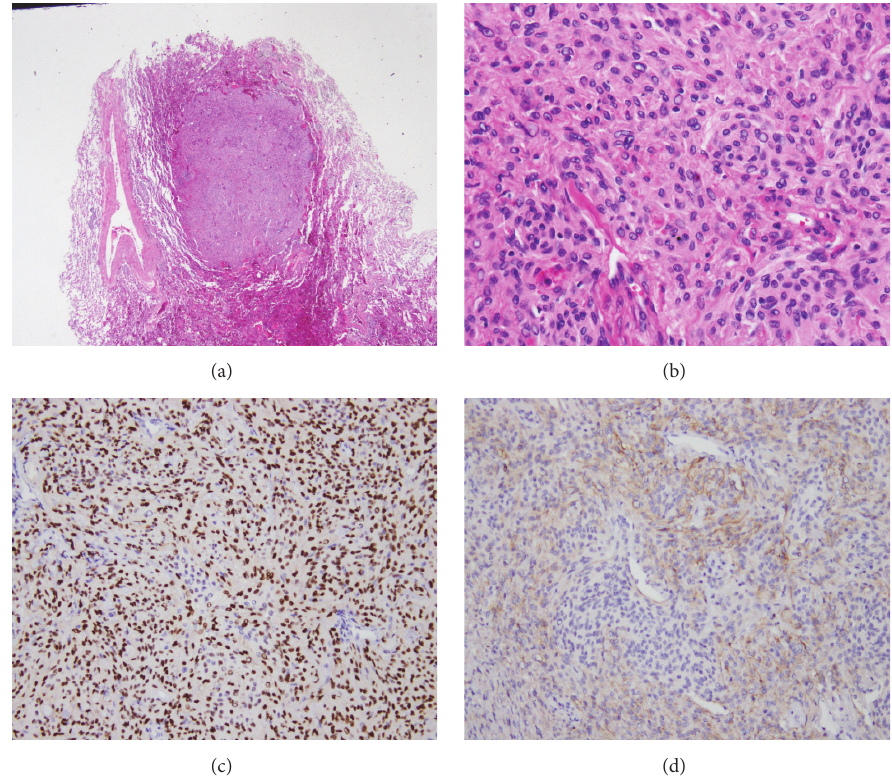
Figure 2: Histological features of the case (surgical lung biopsy specimen). (a) Microscopic examination revealed a well-defined nodule that compressedsurroundinglungparenchyma.Hematoxylin-eosin(HE)40x.(b)Athighpowerview,thetumorincludesnestsofroundtospindle shape cells that present focal whorls pattern. The tumor cells showed clear cytoplasm and round and oval nuclei with delicate chromatin distribution and some intranuclear inclusions. Mitotic figures are not present. Hematoxylin-eosin (HE) 200x. (c) In immunohistochemistry study, the tumor cells showed positive staining for PR (100x) and (d) CD56